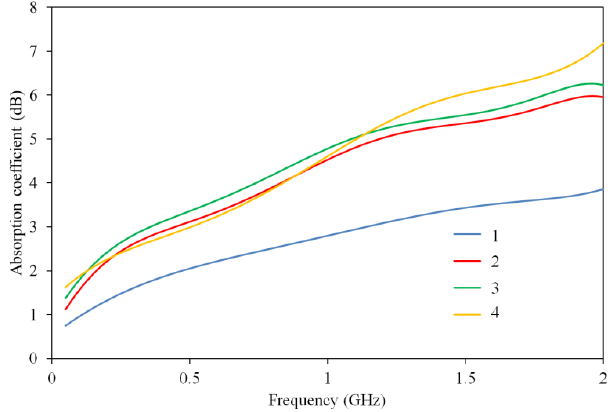
Figure 6. Frequency dependence of the electromagnetic radiation (EMR) absorption coefficient of the PANI films on a polyethylene substrate: 1—110 μm, 2—120 μm, 3—140 μm, and 4—160 μm.